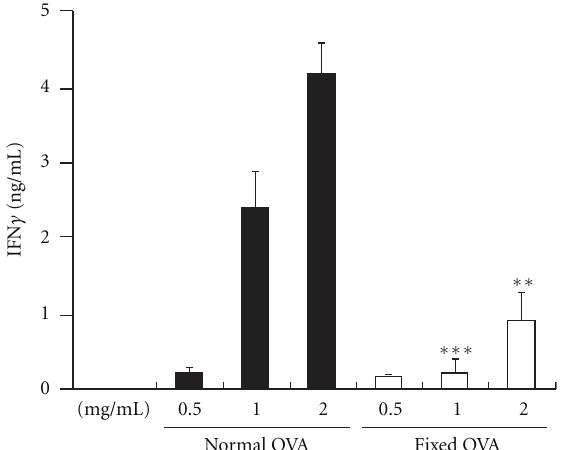
Figure 3: Cross-presentation of fixed OVA is less e ffi cient than native OVA. Graded doses of native and fixed-OVA as indicated were pulsed onto DC2.4cells for three hours. The cells were then fixed and incubated with OTI-CD8 + T cells for 48 hours. The production of secreted IFN γ by the T cells was evaluated by ELISA. ∗∗ P < 0 . 01; ∗∗∗ P < 0 . 001. The results were confirmed in at least two independent